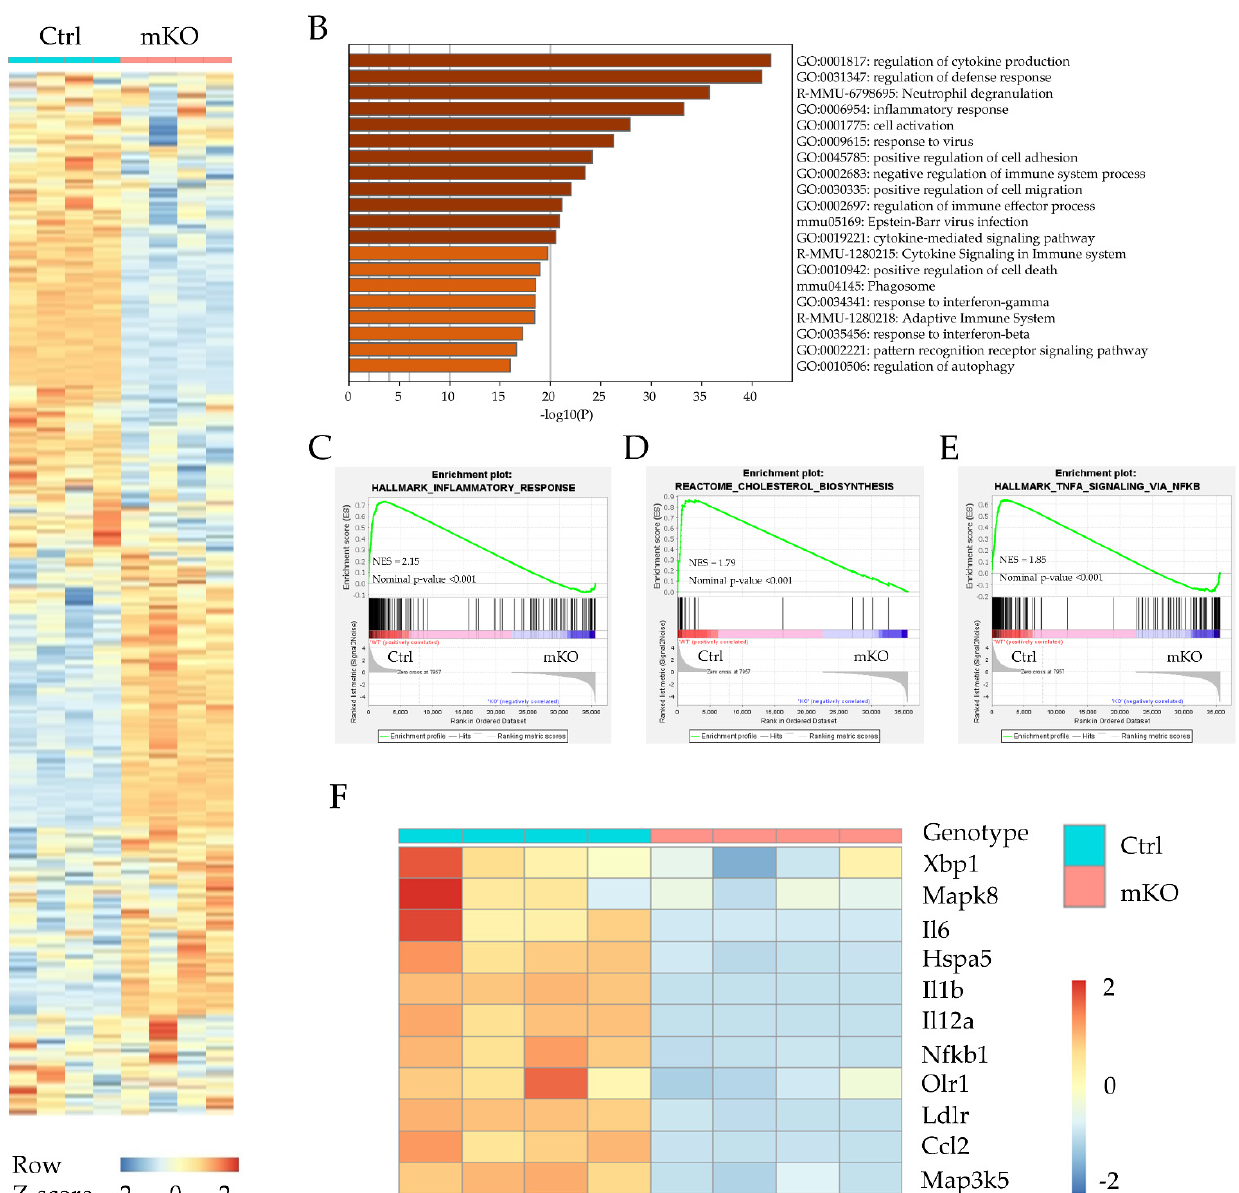
Figure 2. RNA sequencing differential expression analysis between BMDMs from Control (Ctrl) and Tm6sf2 mKO (mKO) mice. ( A ) Heatmap representation depicting the significantly changed genes in BMDMs after oxLDL treatment ( Tm6sf2 mKO compared with the control, padj < 0.05). ( B ) Visualizations of GO enrichment of the significantly changed genes by metascape. Here are the top 20 signif- icant signaling pathways. ( C – E ) Details of selected signaling pathway enrichment plot demon- strated by GSEA analysis, which shows the specific gene distribution and correlation with control and mKO BMDMs. ( F ) Heat map representation depicting the expression of genes associated with inflammatory, ER stress, and cholesterol transport in BMDMs upon oxLDL stimulation ( Tm6sf2 mKO compared with the control. p ≤ 0.01 and log2-fold change ≥ 0.5, the color bar indicates z-score in heatmap).